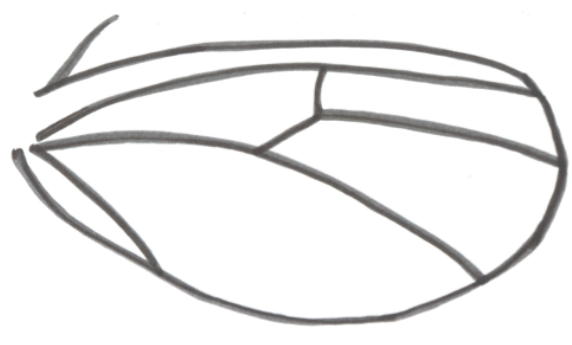
Figure 1. Hindwing venation of Ceryx mirabilis